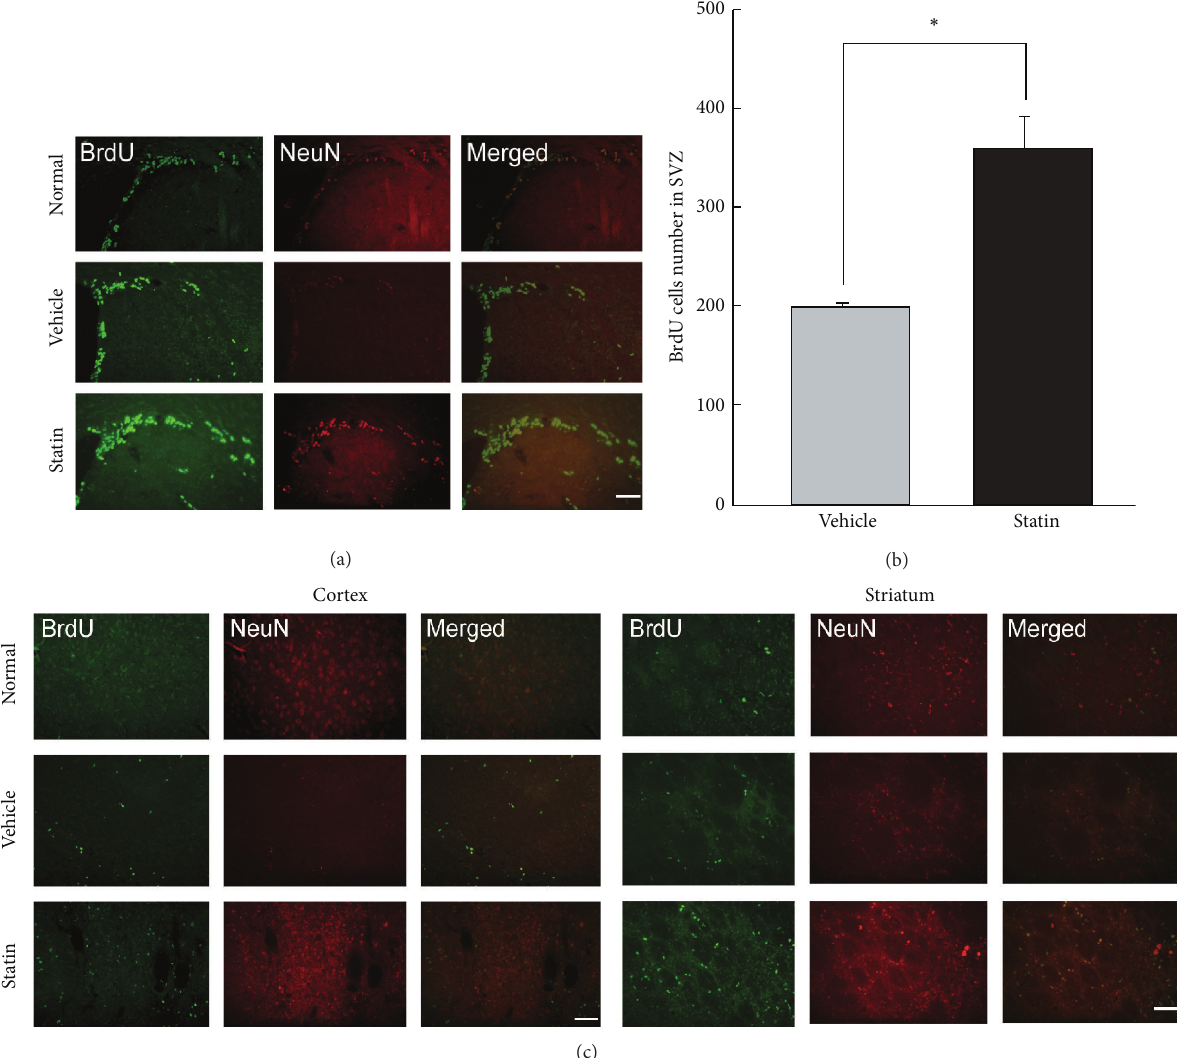
Figure4:Neurogenesisafterischemicinjuryinnormalandvehicle-oratorvastatin-treatedgroup.(a)CellproliferationinSVZoftheischemic hemisphere is identified by BrdU (green) and NeuN (red) immunoreactivity. Many BrdU-positive cells are shown in the SVZ of both groups, withincreasedBrdU-positivecellsinthestriatumoftheatorvastatin-treatedgroup.(b)AquantitativegraphrepresentingthenumberofBrdU- positive cells, which is increased in the atorvastatin-treated group compared with the vehicle-treated group in the SVZ. (c) The migration of the proliferated cells is identified in the cortex and striatum each stained with BrdU (green) and NeuN (red). Scale bars = 20 𝜇